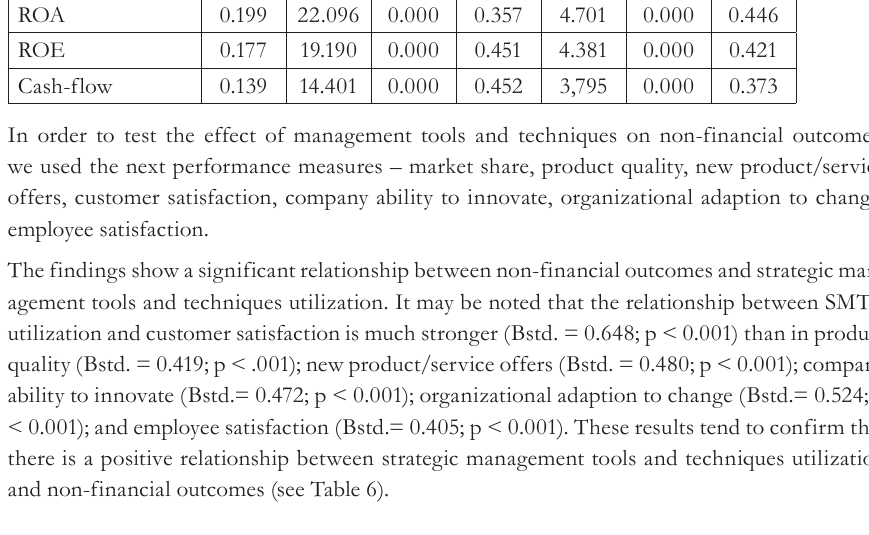
Tab. 6 – The results of the regression model for the non-financial performance outcomes of strategic management tools and techniques utilization. Source: Own